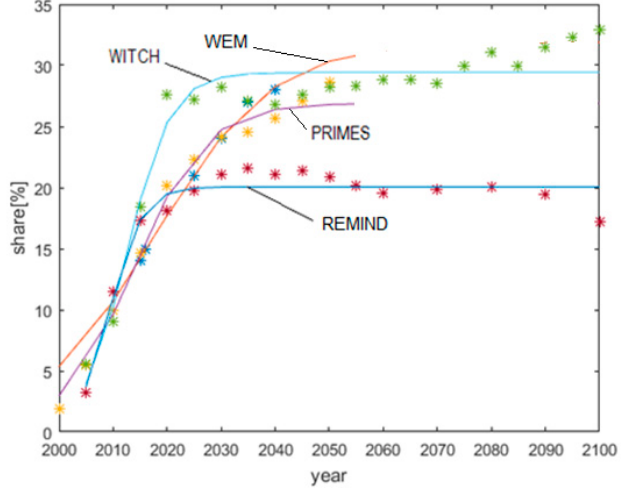
Figure 13. Reference scenarios for WEM, WITCH, PRIMES and REMIND programs for Europe’s wind power capacity share (own work).